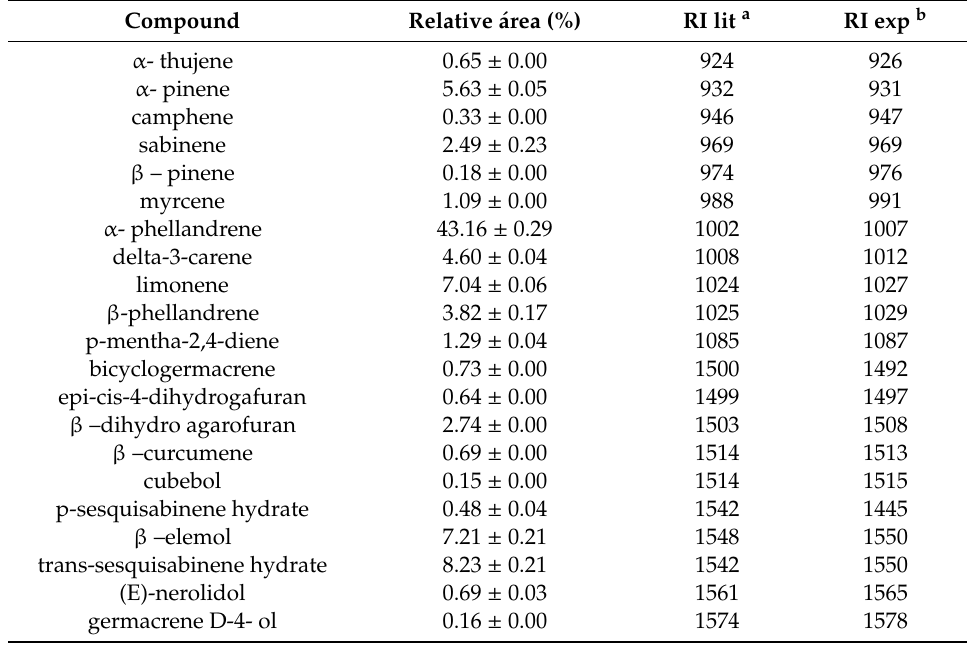
Table 1. Chemical composition of the essential oil of Piper